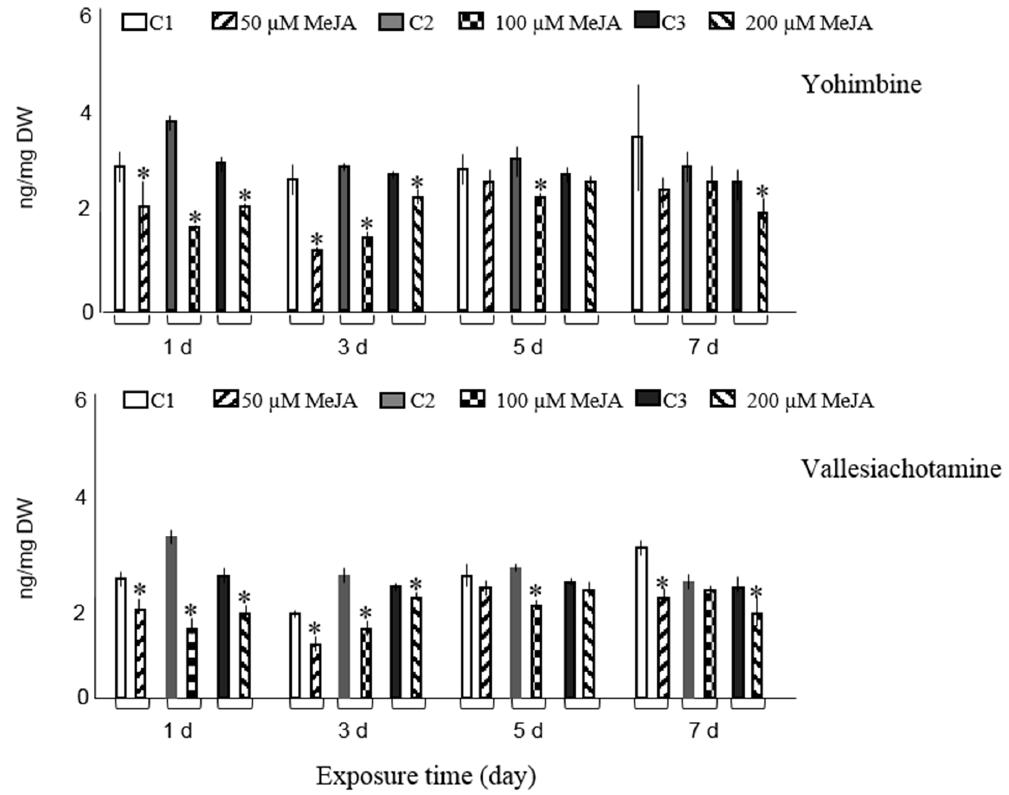
Figure 1. Accumulation of ten major alkaloids analyzed by GC-MS in R. stricta hairy roots elicited with 50, 100, and 200 µM MeJA after 1, 3, 5, and 7 days (d) exposure time. Control cultures (C1, C2, and C3) contained equal volume of 40% ethanol. Pairwise comparison of means from two groups (control versus elicited sample) is presented as mean ± SD of three samples for each treatment. * indicates significant difference in the mean between control and elicited sample (student’s t test, p < 0.05).